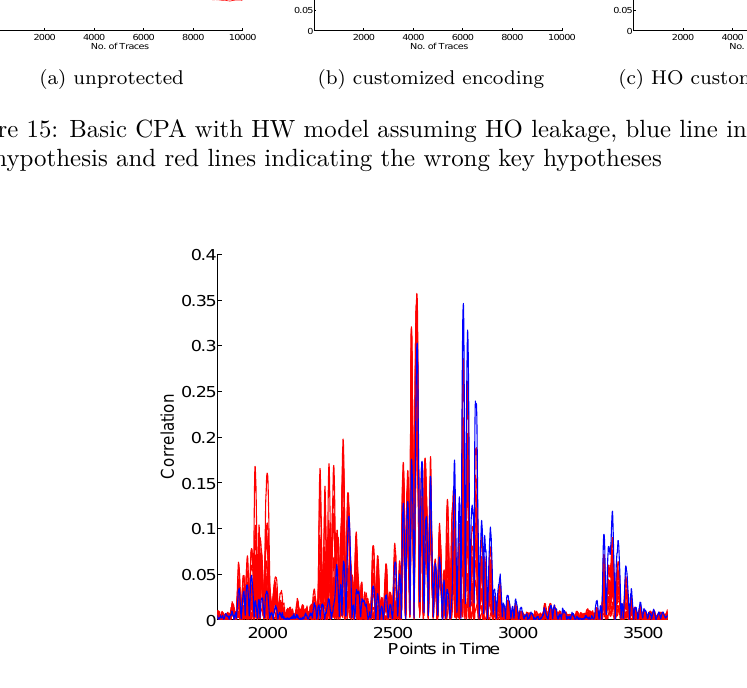
inaccurate. However, it is hard to perform the exact 32 bits due to high